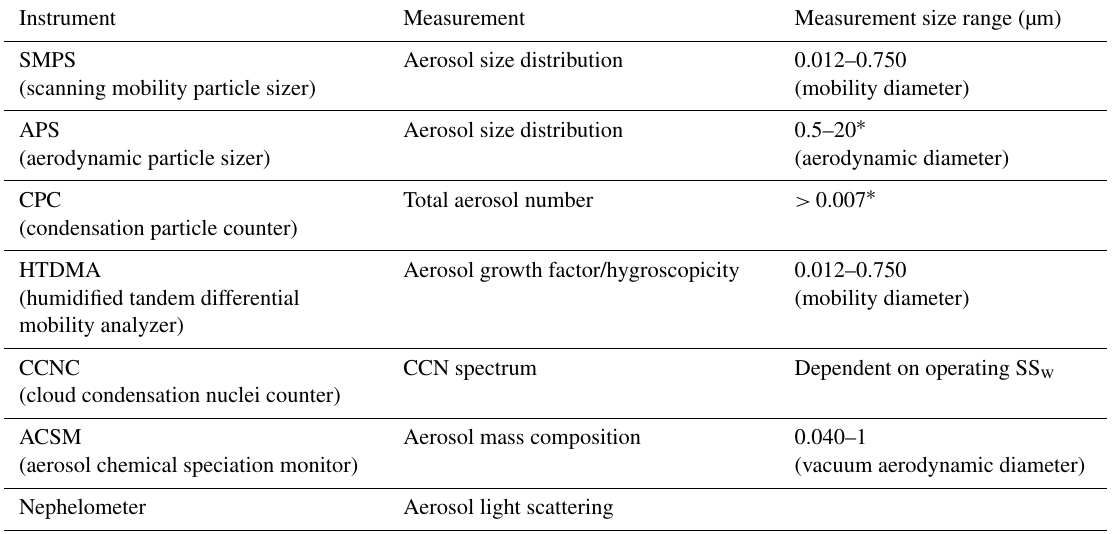
Table 1. Base measurements used in the dataset